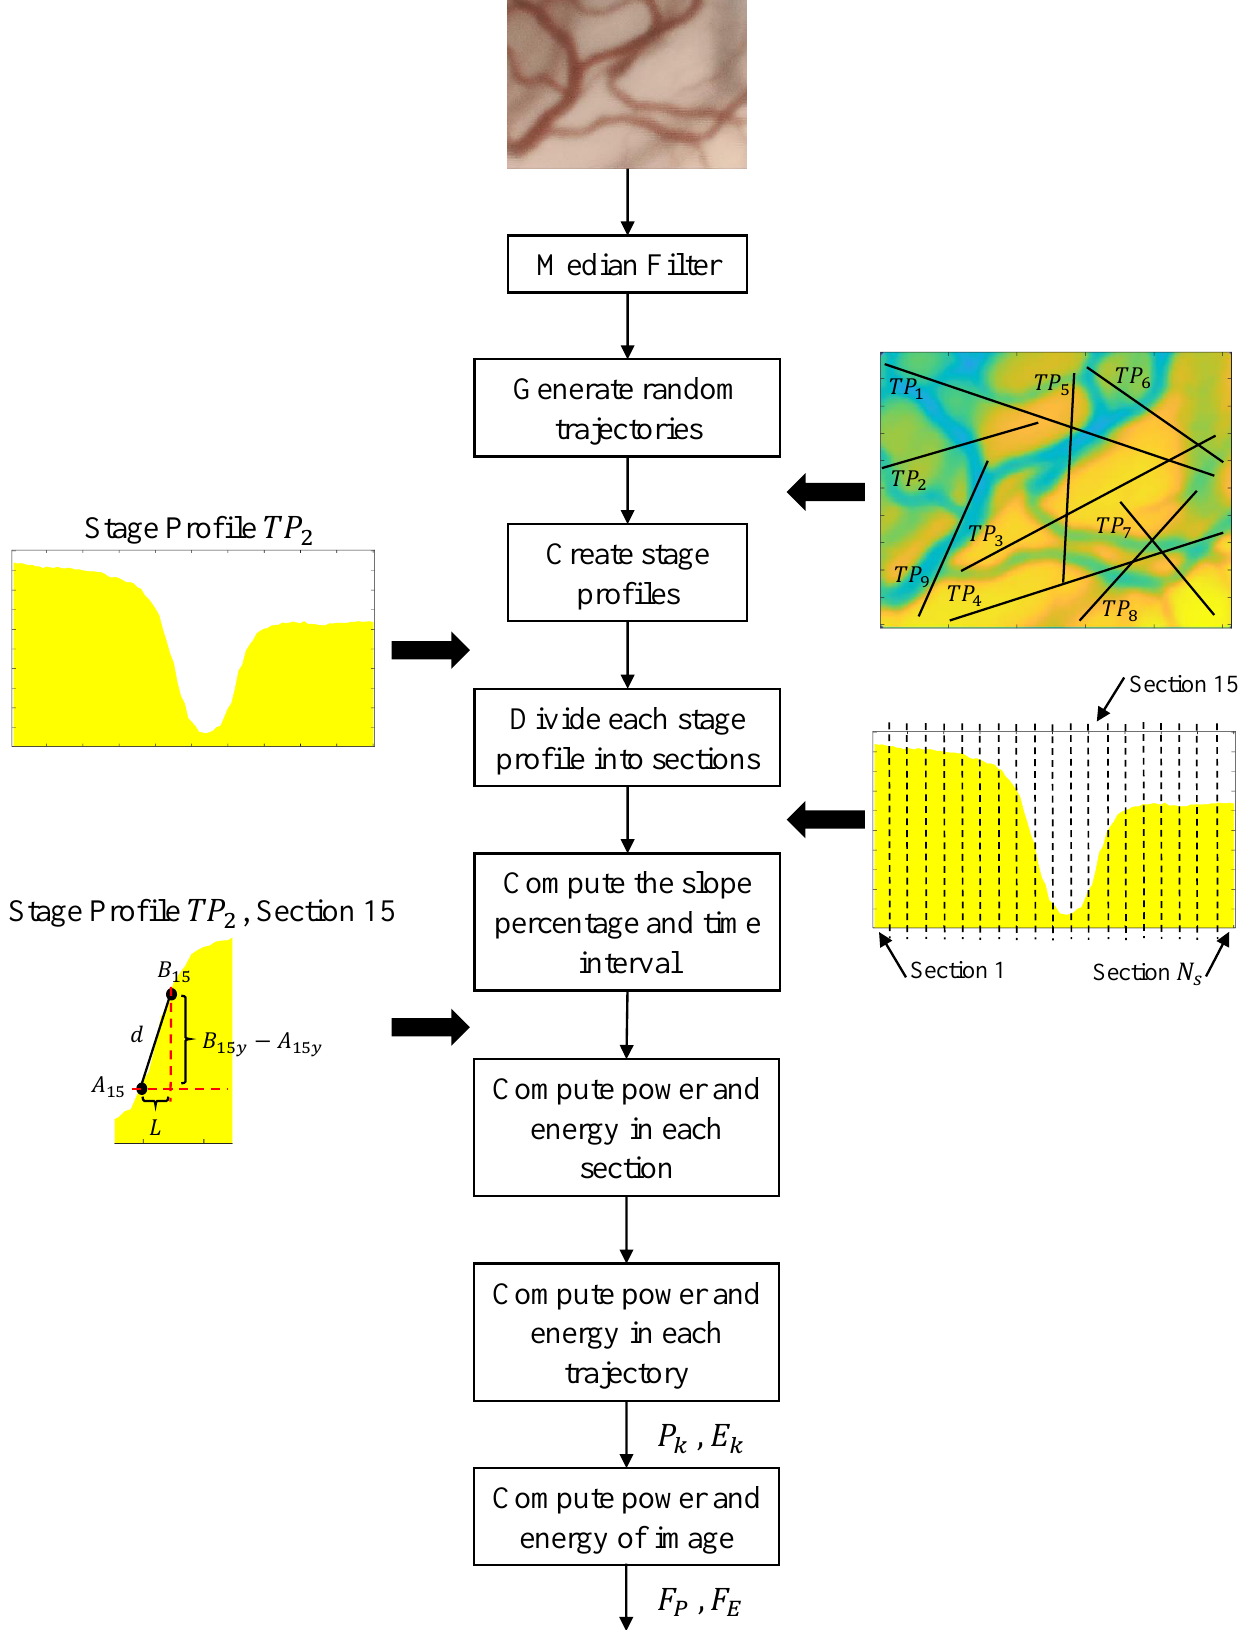
Figure 2. Feature extraction